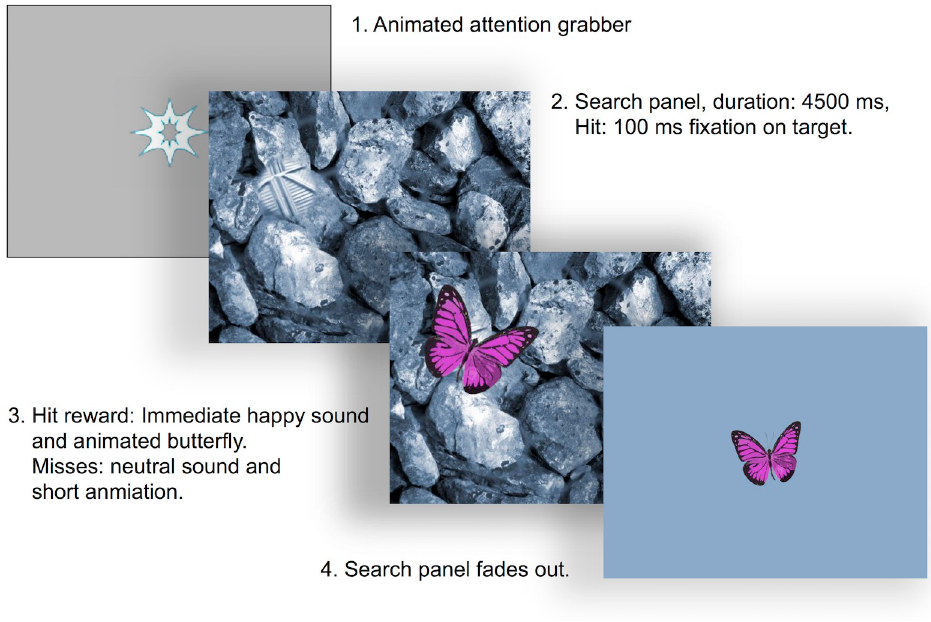
Fig 3. Trial example. This example shows one trial with a monochromatic blue search stimulus, and one of the five butterflies that were alternated as rewards. Each trial included a central attention grabber of 5˚ vis in diameter. As soon as the infant’s gaze rested on its central area (2.5˚ vis in diameter) for 100 ms, one of the search stimuli was shown for a maximum of 4500 ms. If the infant’s gaze rested on the target patch before timeout for at least 100 ms, rewarding music started to play, then a colorful butterfly loomed out of the target’s center and moved to the center of the screen, and the trial ended. If a target was missed, the butterfly was only shown for a shorter time, accompanied by a neutral sound. Directly after the butterflies disappeared, a new trial started. Every fifth trial, an attention grabber was shown at a peripheral location in addition to the central location. If the infant’s gaze was not recorded within the central region of the attention grabber—for example because of inattentiveness or changes in the distance between the eyes and the eye-tracking camera—an additional calibration was initiated and the camera set-up was corrected if necessary. The length of the full trial varied due to when infants fixated on the attention grabber, and whether they detected the